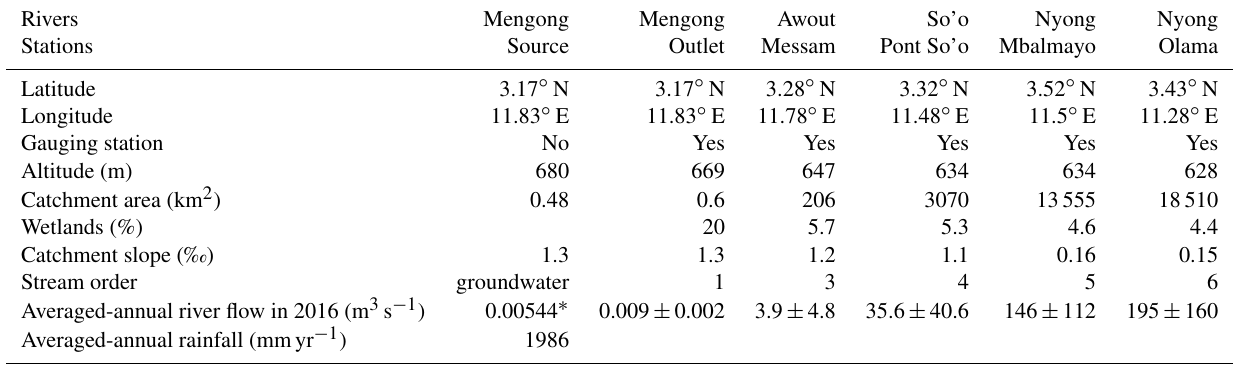
Table 1. Geographical and hydrological sub-catchments characteristics.